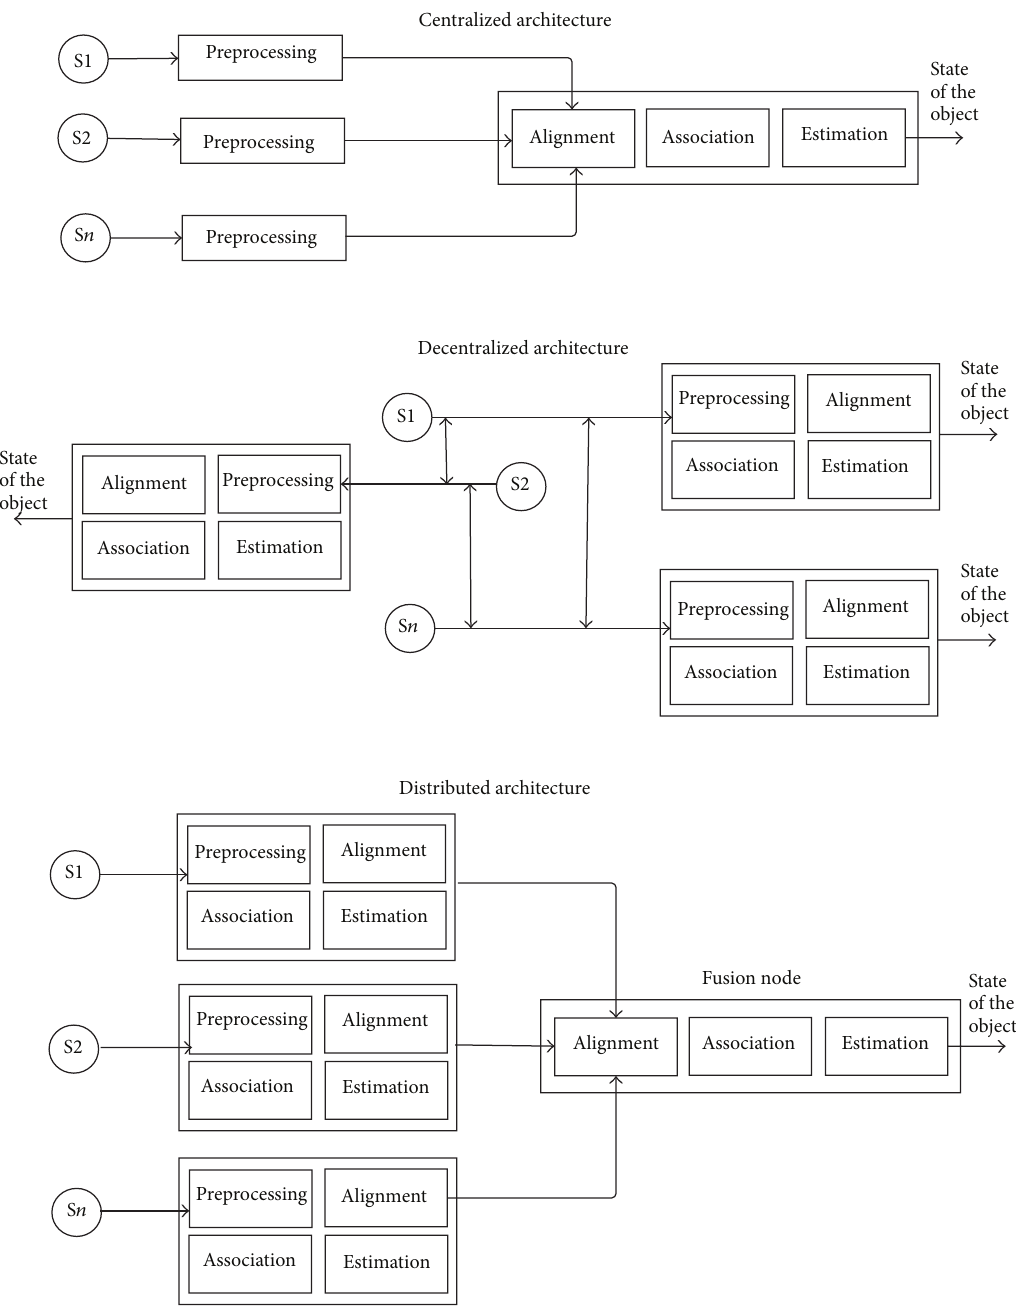
Figure 4: Classification based on the type of